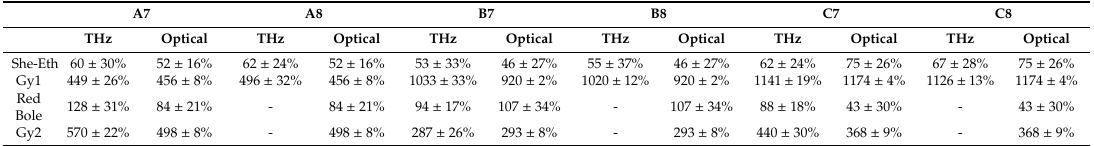
Table 4. THz estimate and optical measurement of layer thickness (in microns) of six areas covered by Sandrac-based varnish.